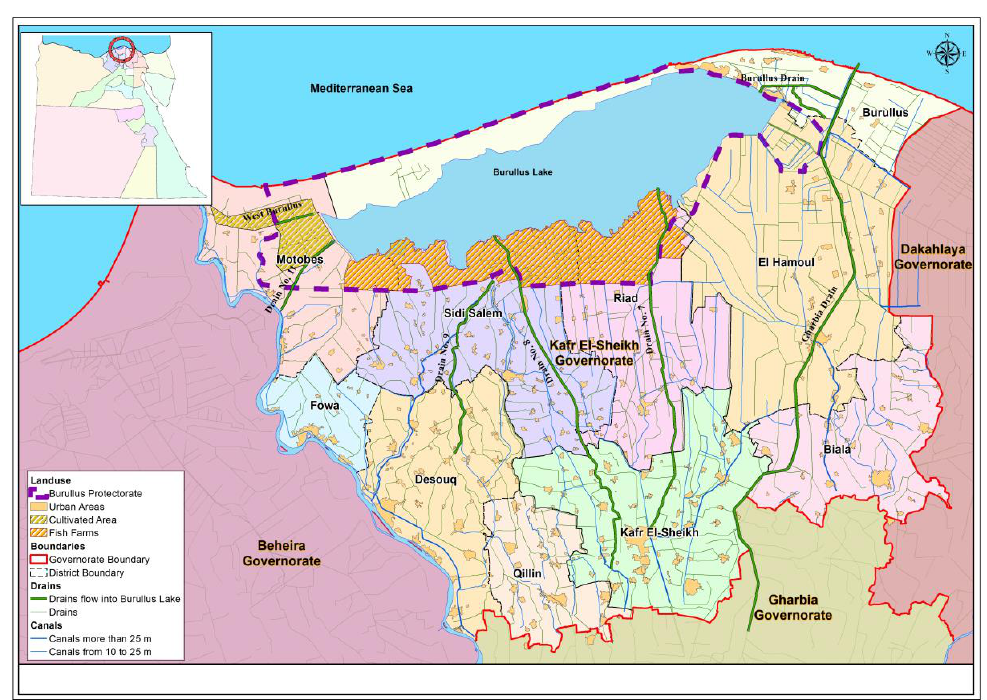
Figure 1. Lake Burullus Protectorate and seven main agricultural drains discharging to the